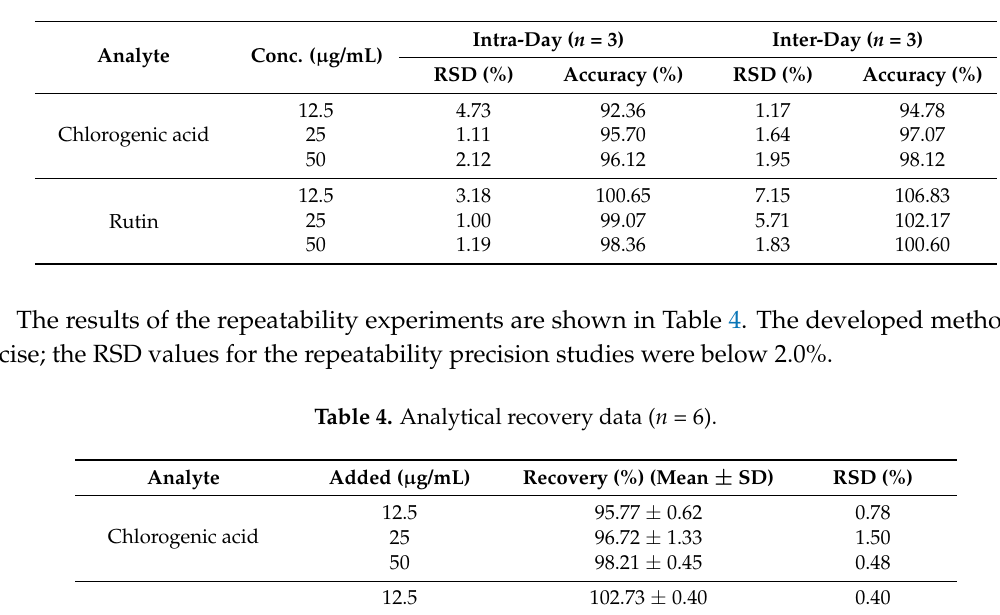
Table 3. Analytical results of intra-day and inter-day precision and accuracy.